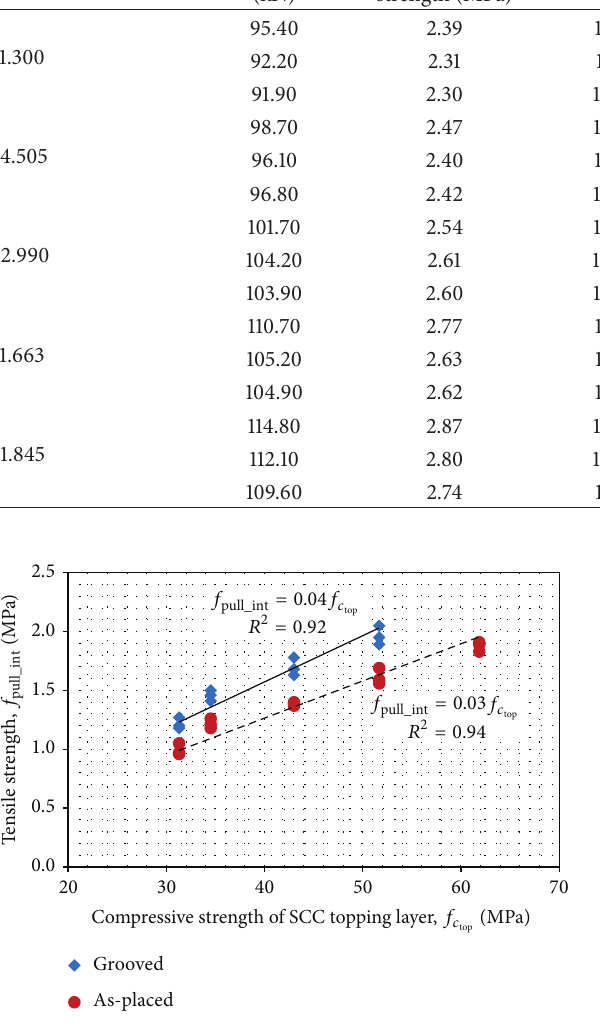
Figure 6: Interfacial tensile strength with different substrate surface conditions and different compressive strength of SCC topping